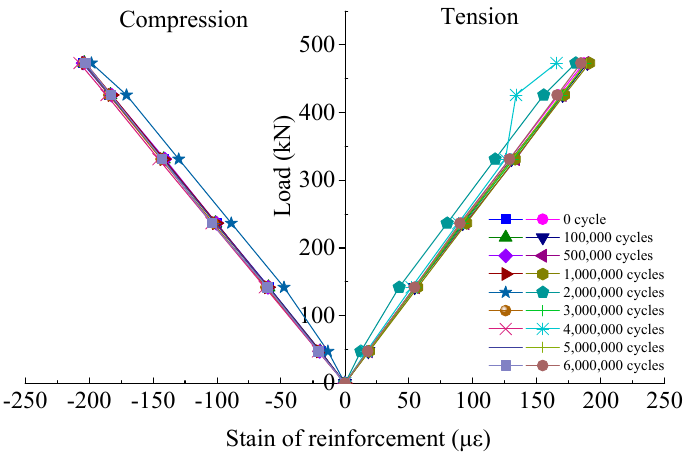
( e ) Figure 16. Distribution of concrete strain along height: ( a ) section A-A; ( b ) section B-B; ( c ) section C-